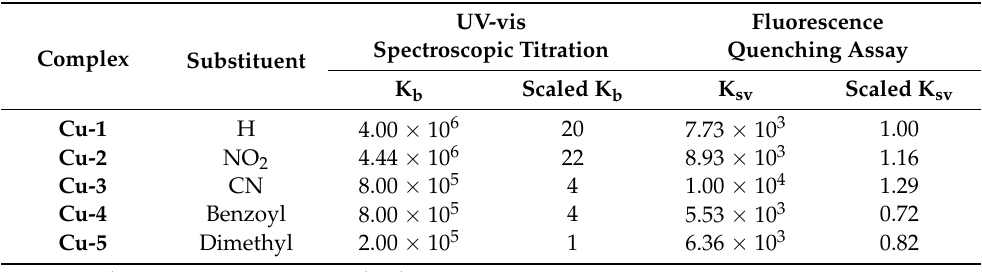
Table 2. Intrinsic-Binding Constants and Competitive Quenching Constants for Cu-1 – Cu-5 .